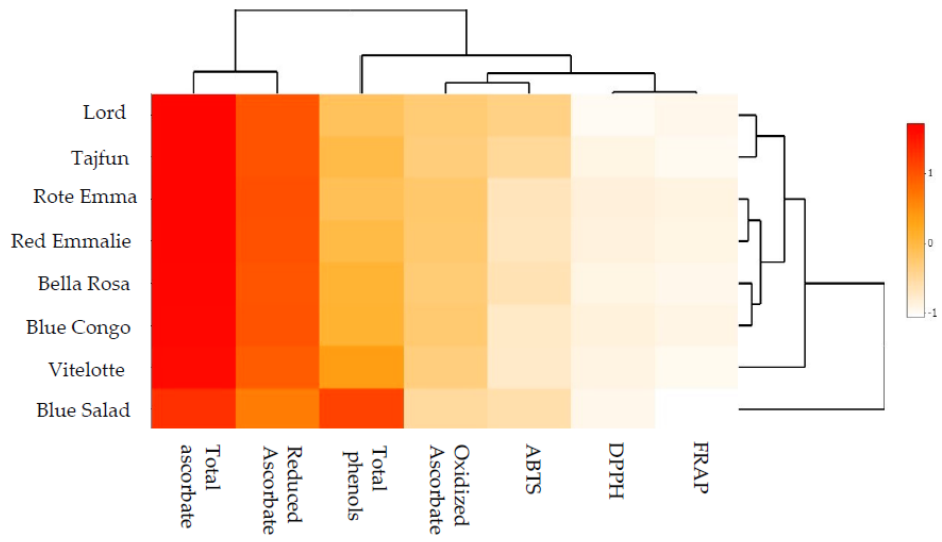
Figure 1. Scaled heat map for potatoes with different skin and flesh colours in terms of antioxidant activity. Darker colour means greater dependence between research factors (higher correlation coefficient). The diagrams on the outside are the reference for cluster analysis.